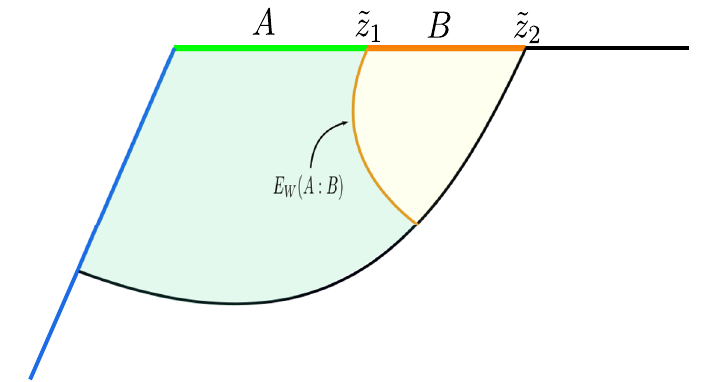
Figure 13. Schematics of the entanglement wedge cross section for the two adjacent intervals in phase-II conformally mapped the static mirror